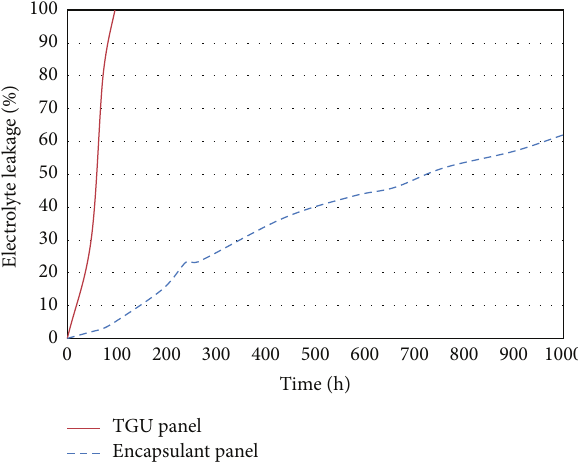
Figure 11: Electrolyte leak rate over time for the